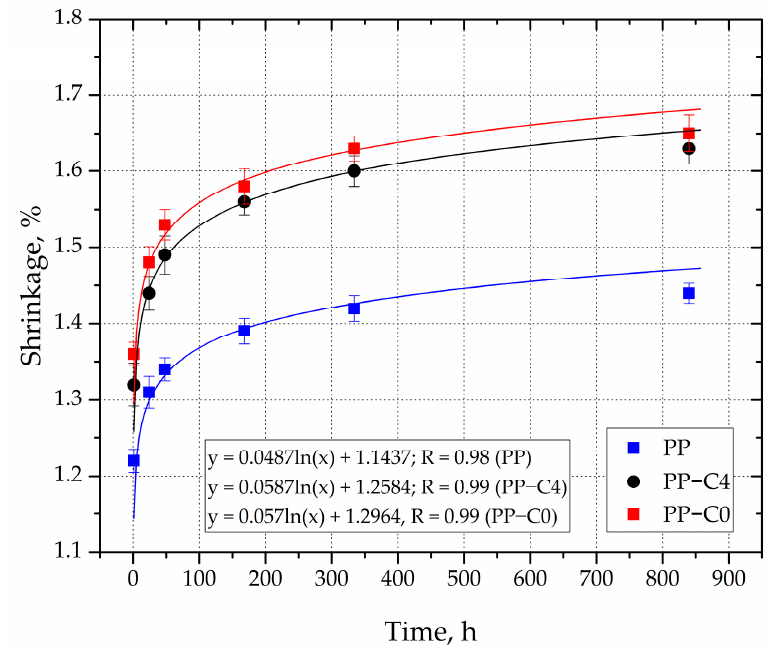
Figure 7. Changes of processing shrinkage values as a function of the conditioning time.